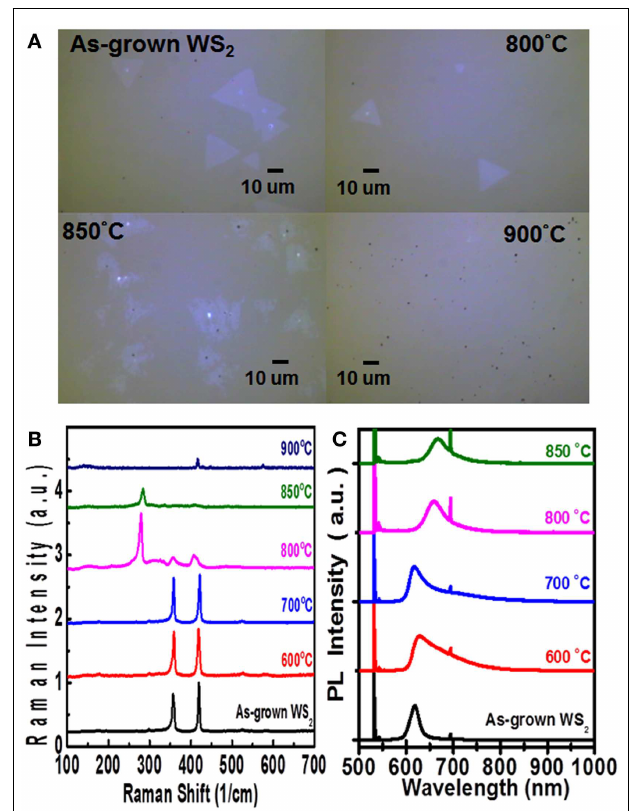
FIGURE 7 | (A) Optical images, (B) Raman spectra, and (C) PL spectra for theWS 2 monolayer flakes after selenization at various temperatures are shown.